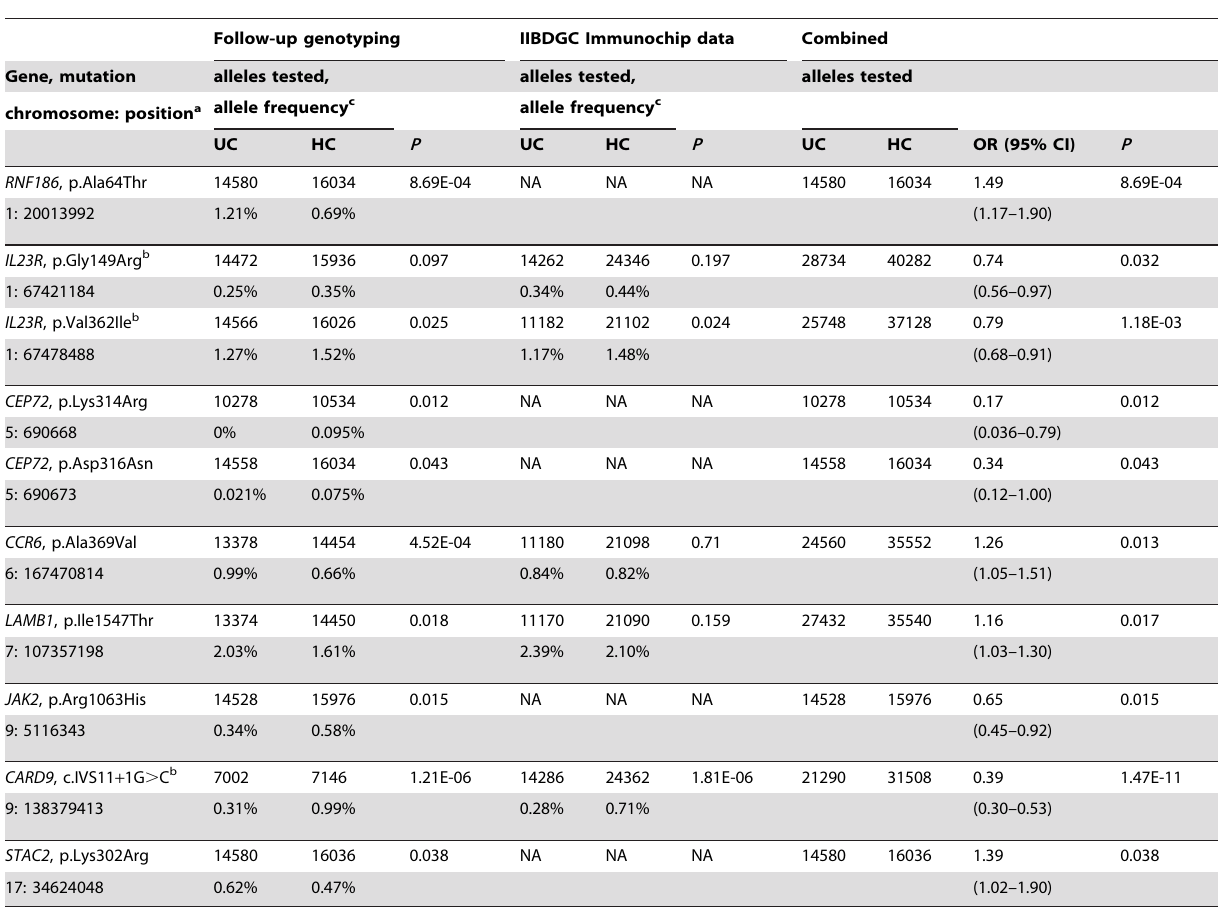
Table 1. Identification of rare variants associated with ulcerative colitis.